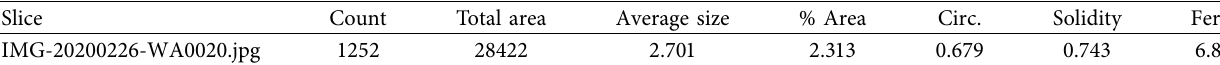
Table 3: Analyzed values at 680 ° c.